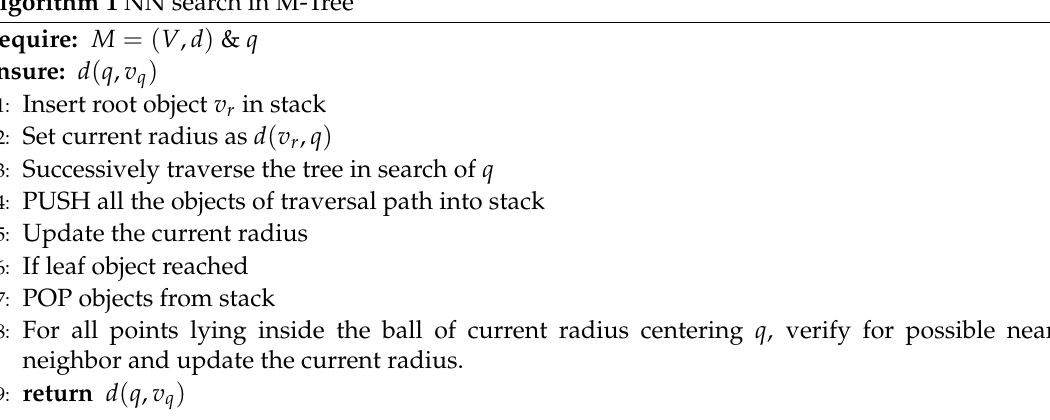
Algorithm 1 NN search in